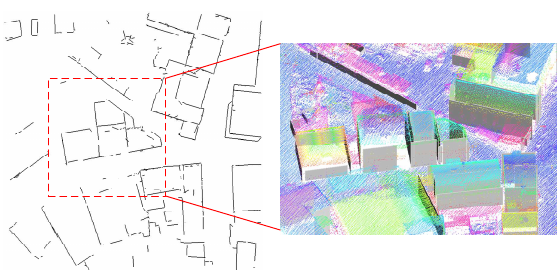
Figure 6. Extracted wall facades in the Enschede